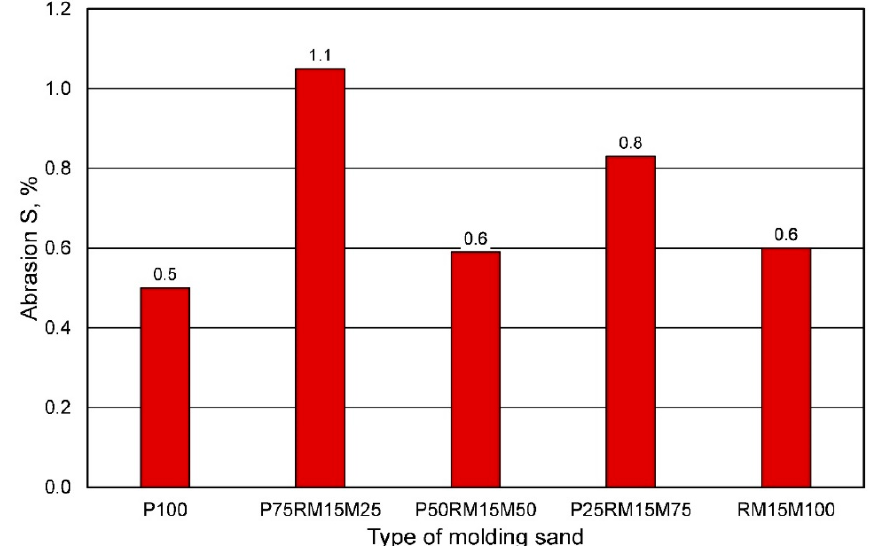
Figure 23. Abrasion S of the molding sand, depending on the sand matrix